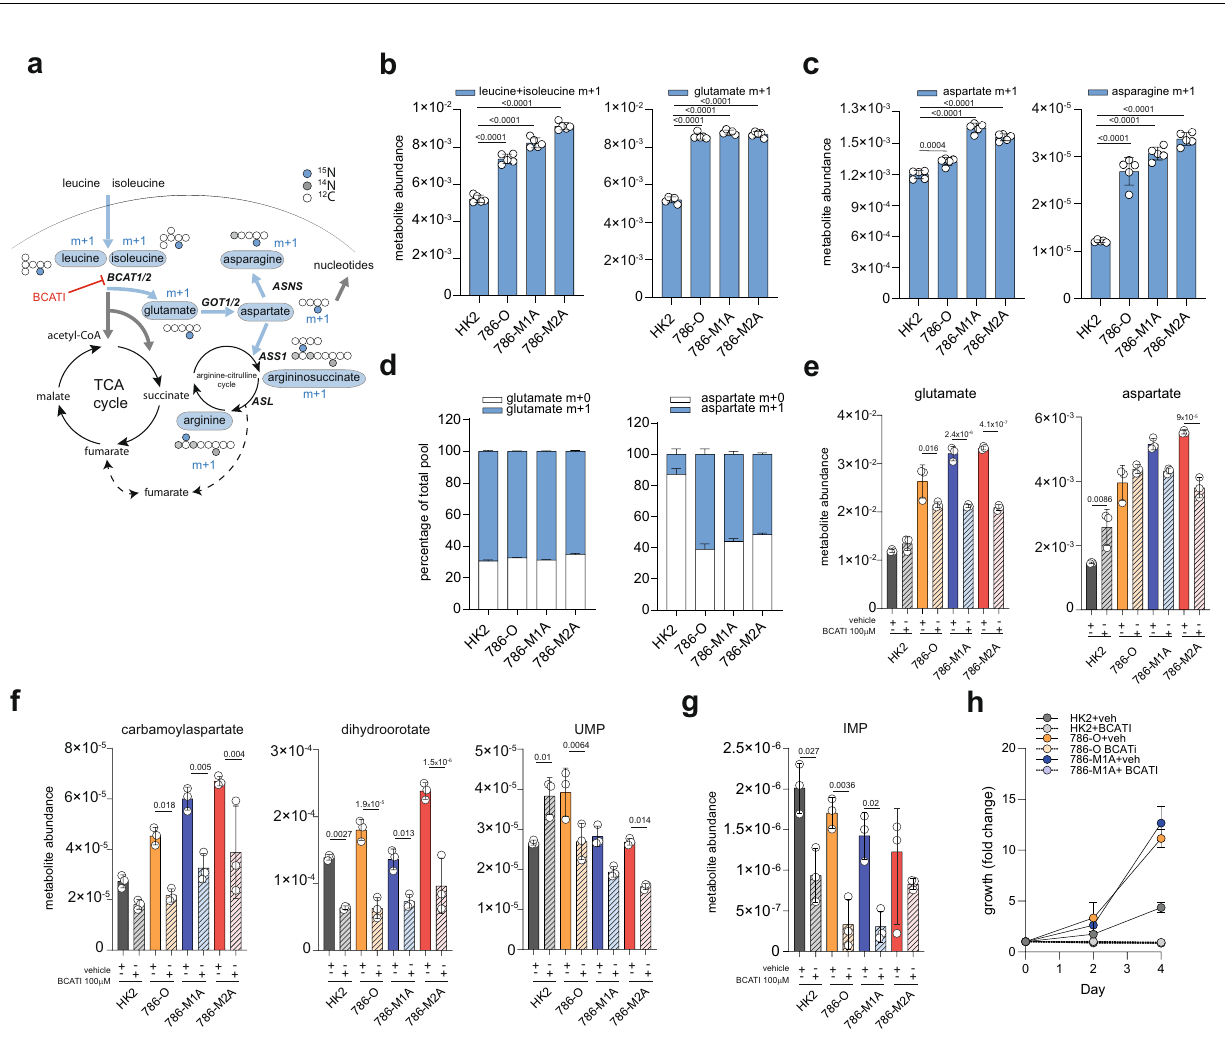
Fig. 3 | ocEAn, a tool to visualize metabolic changes in cancer cells. a Representative scatter plot generated using ocEAn for BCAT1 in the indicated comparisons. Metabolites upstream and downstream of BCAT1 directly or indir- ectly linked to reaction are indicated in two separate plots, one (on top) for con- version of leucine in ketoisocaproic acid (KIC), the other (on the bottom) for the transamination of α -ketoglutarate (aKG) to glutamate. The dot size represents the multiplicationofthe t -valuewiththeweighteddistanceindex(distanceindexbeing the number of the x -axis). y -axis reports the t -value of the abundances for the metabolites indicated in BCAT1 footprint including if they are accumulated or